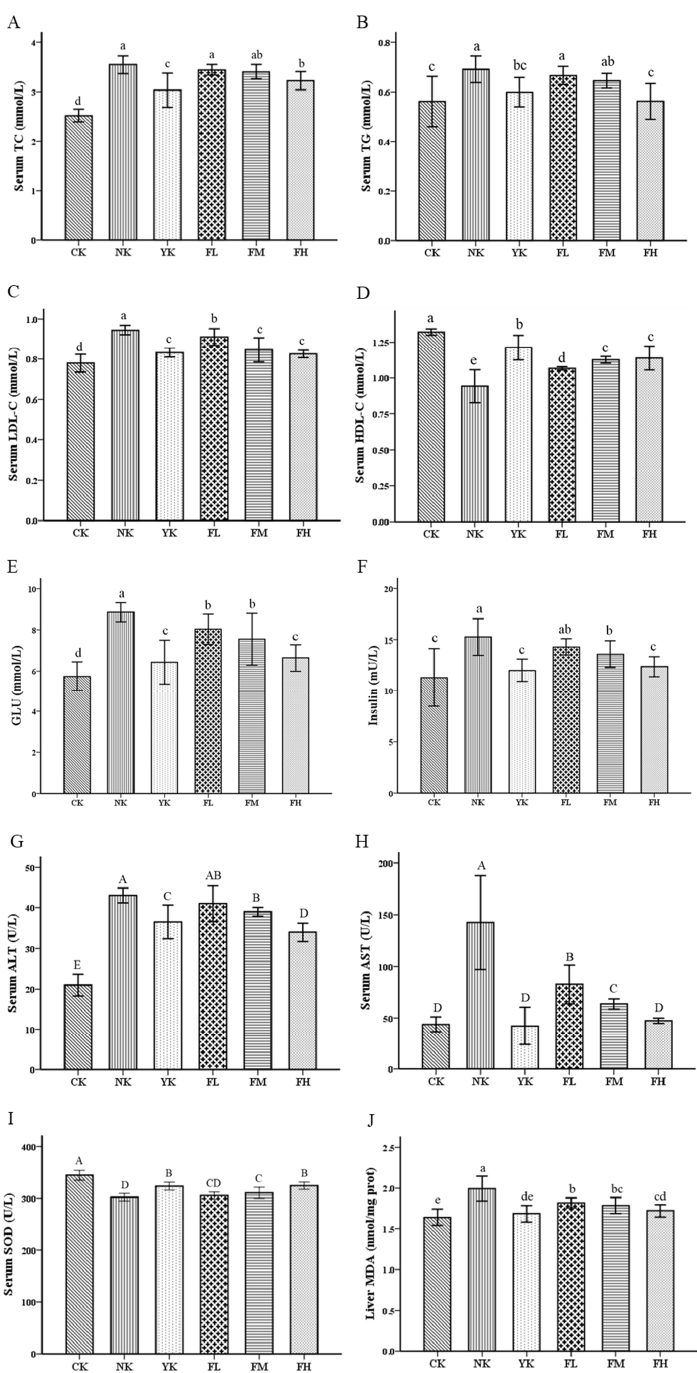
Figure 2. CFBT improves serum biochemical indexes. ( A ) Serum total cholesterol (TC), ( B ) serum triglyceride (TG), ( C ) serum low-density lipoprotein cholesterol (LDL-C), ( D ) serum high-density lipoprotein cholesterol (HDL-C), ( E ) serum glucose (GLU), ( F ) serum insulin, ( G ) serum alanine aminotransferase (ALT), ( H ) serum aspartate aminotransferase (AST), ( I ) liver superoxide dismutase (SOD) and ( J ) liver malondialdehyde (MDA). CK, control group; NK, high-fat diet group; YK, high-fat diet with positive drug Xuezhikang; FL, high-fat diet with low-dosage CFBT; FM, high-fat diet with medium-dosage CFBT; FH, high-fat diet with high-dosage CFBT. All data are presented as the mean ± SD ( n = 10/group). Different lowercase letters above the bars showed significant difference at 0.05 level among the same data series; different capital letters showed highly significant difference at 0.01 level among the same data